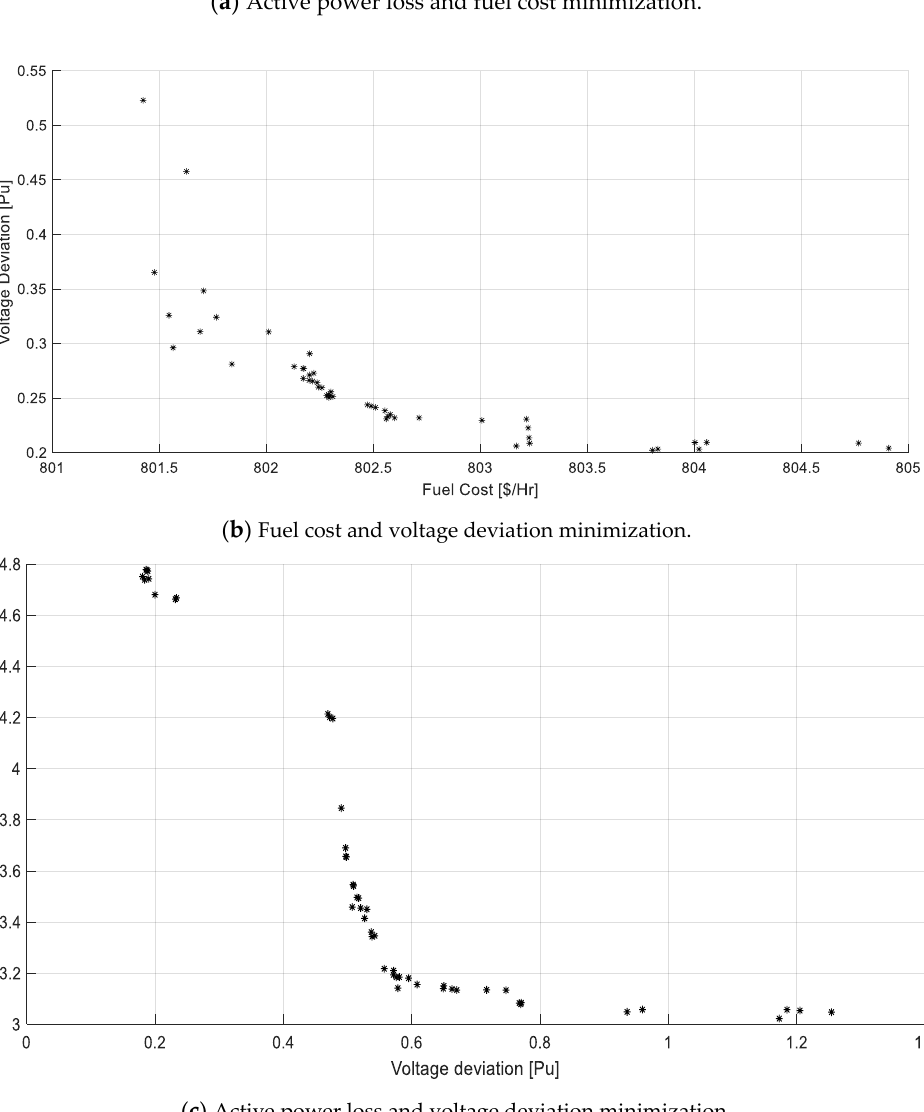
Figure 6. Pareto fronts for bi-objective NSWOA OPF for IEEE-30 bus test